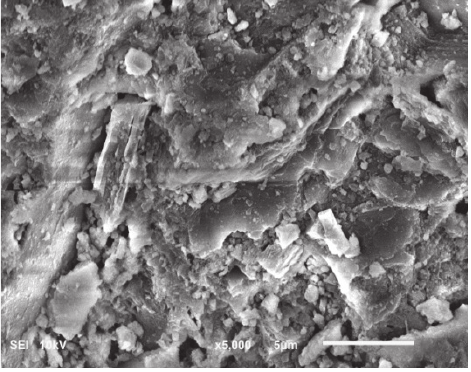
Figure 15: SEM images of Pd/Al 2 O 3